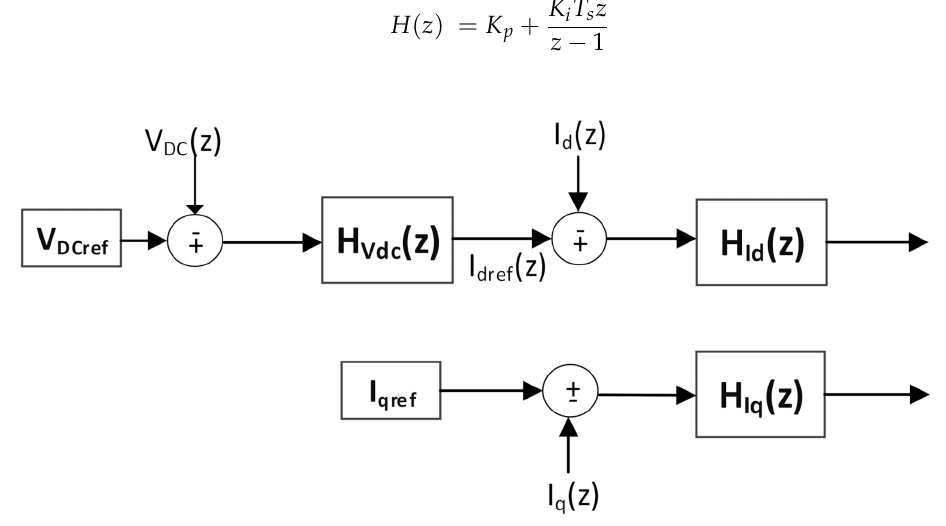
Figure 13. PI controller for voltage and